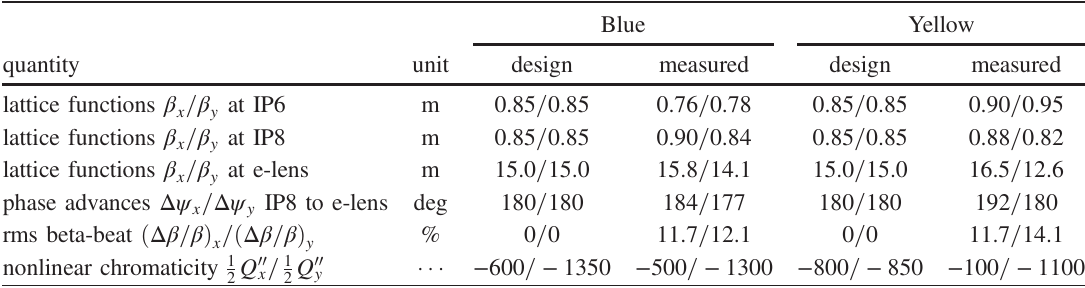
TABLE III. Design and measured lattice functions, phase advances and nonlinear chromaticities.